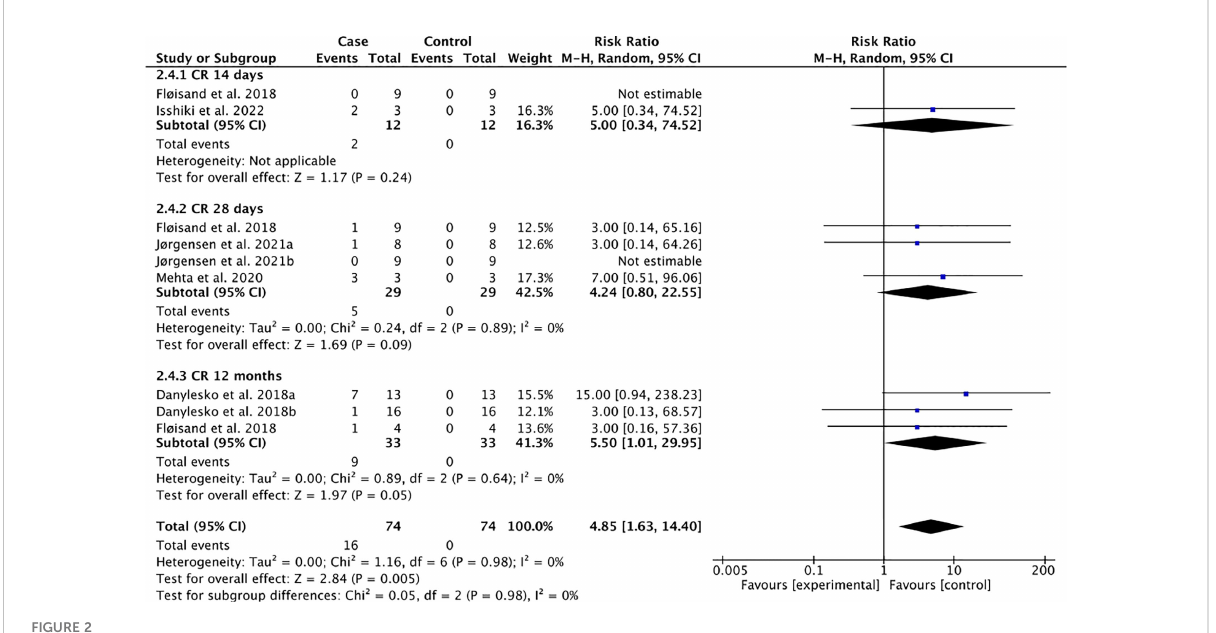
thrombotic microangiopathy (n = 1), and mediastinitis (n = 1).